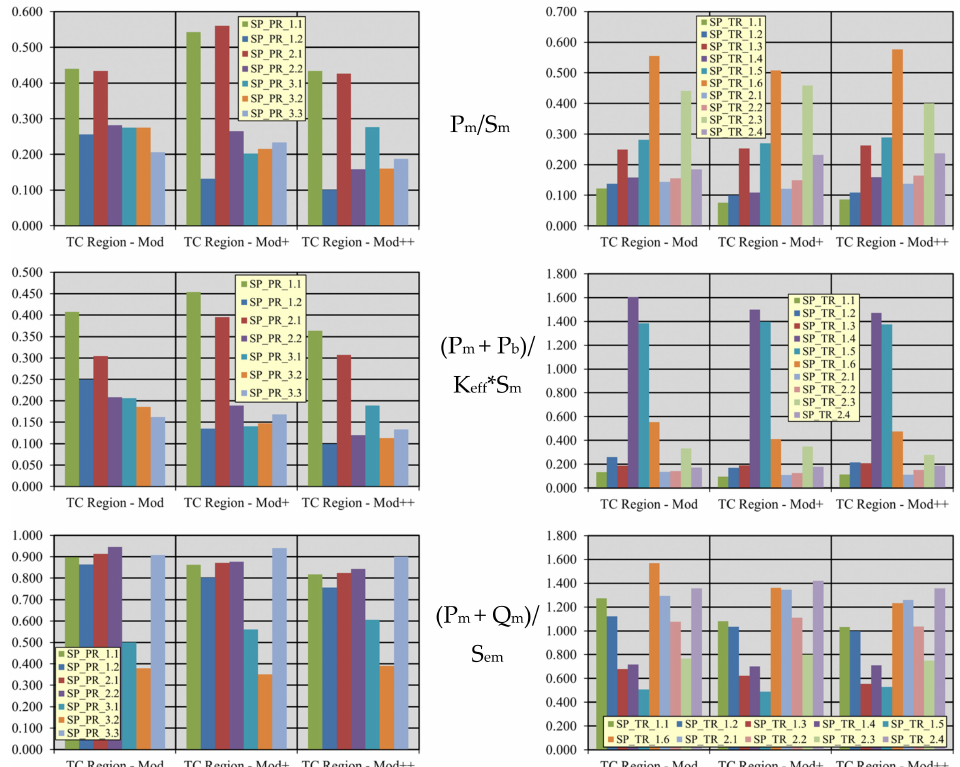
Figure 15. Trends of Level A criteria verification for SPs.